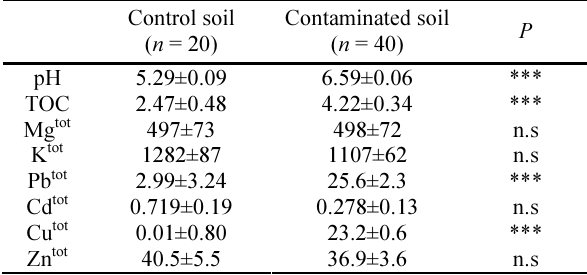
Table 1. Mean soil pH, TOC and total and bioavailable metals in control and contaminated soils. ± (Standard